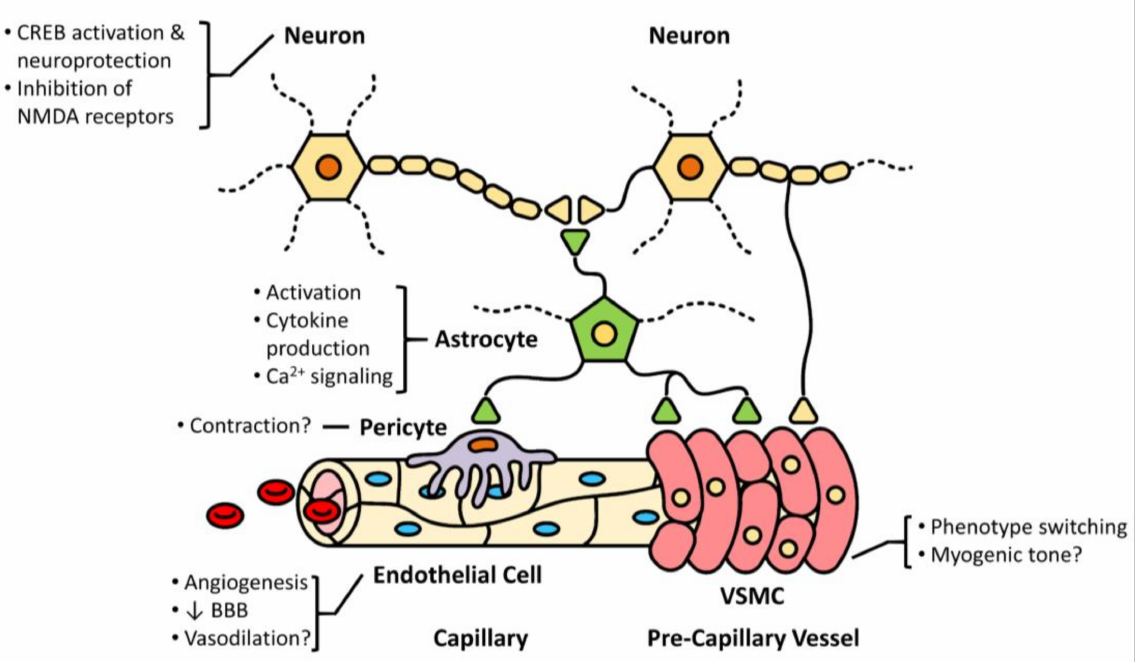
Figure 2. TRPC6 and the neurovascular unit regulating homeostatic cerebral blood flow. Depicted are the cellular constituents at the capillary and precapillary levels, as well interactions with neurons and astrocytes. The cell-specific roles of TRPC6 in the context of ischemic stroke, both established and conceptualized, are provided. There is evidence that TRPC6 is expressed in neurons, astrocytes, pericytes, endothelial cells, and vascular smooth muscle cells (VSMC). For more details refer to Section